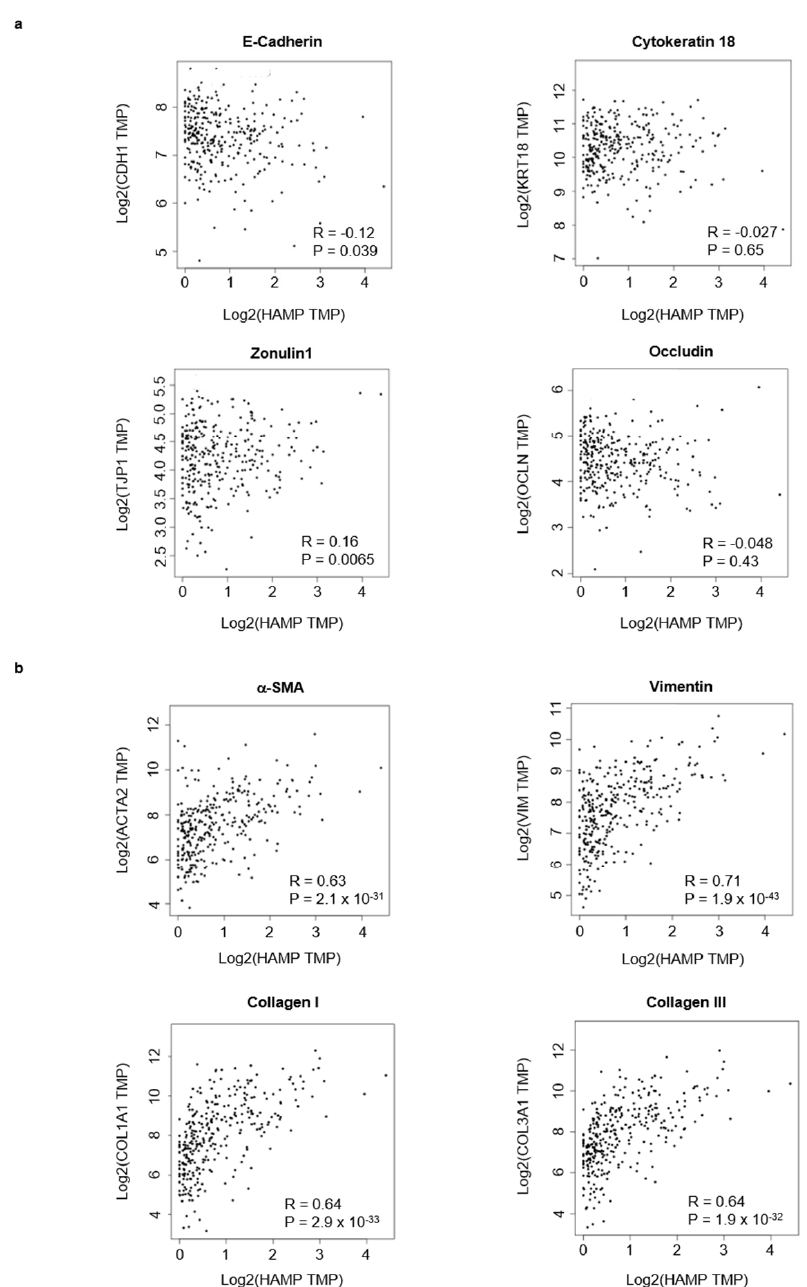
Figure 7. Hepcidin expression correlates with epithelial-to-mesenchymal transition-associated markers in CRC. ( a ) Scatterplots of the correlations between hepcidin expression and epithelial markers using the GEPIA database. ( b ) Scatterplots of the correlations between hepcidin expression and mesenchymal markers using the GEPIA